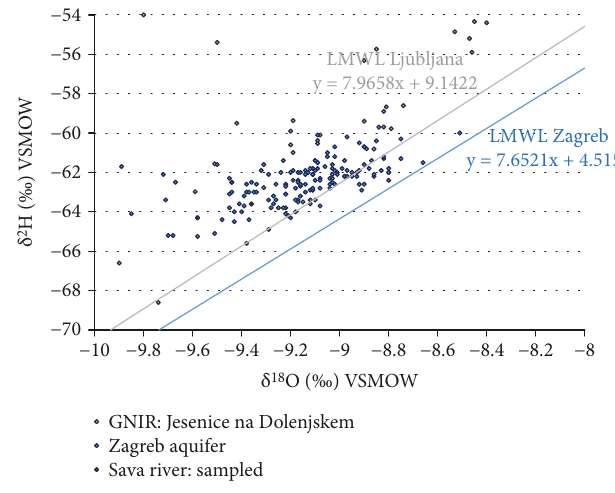
Figure 4: Water stable isotope